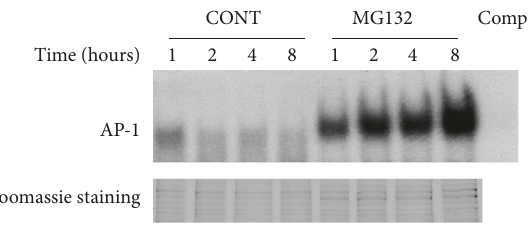
Figure 4: Proteasome inhibition can activate AP-1.